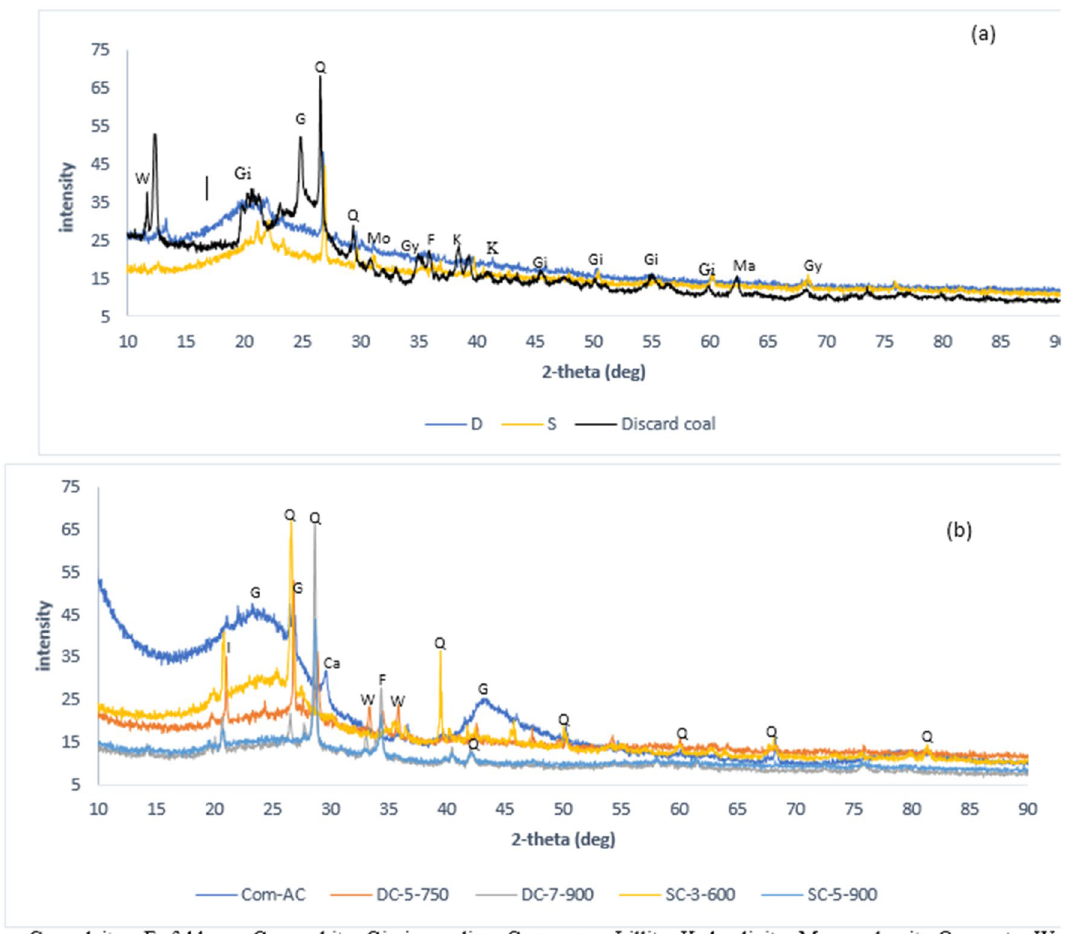
Figure 9. XRD graph of feedstock ( a ), SBAC and Com-AC ( b